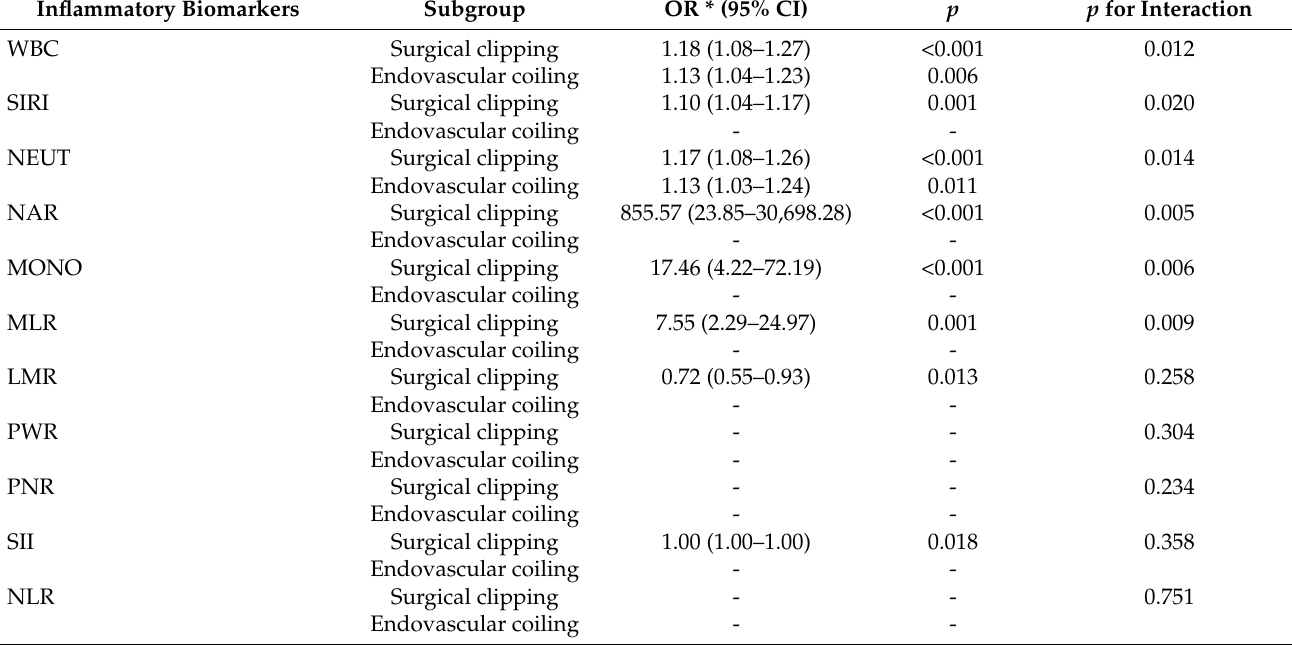
Table 4. Treatment mortality subgroup analysis of 90-day unfavorable